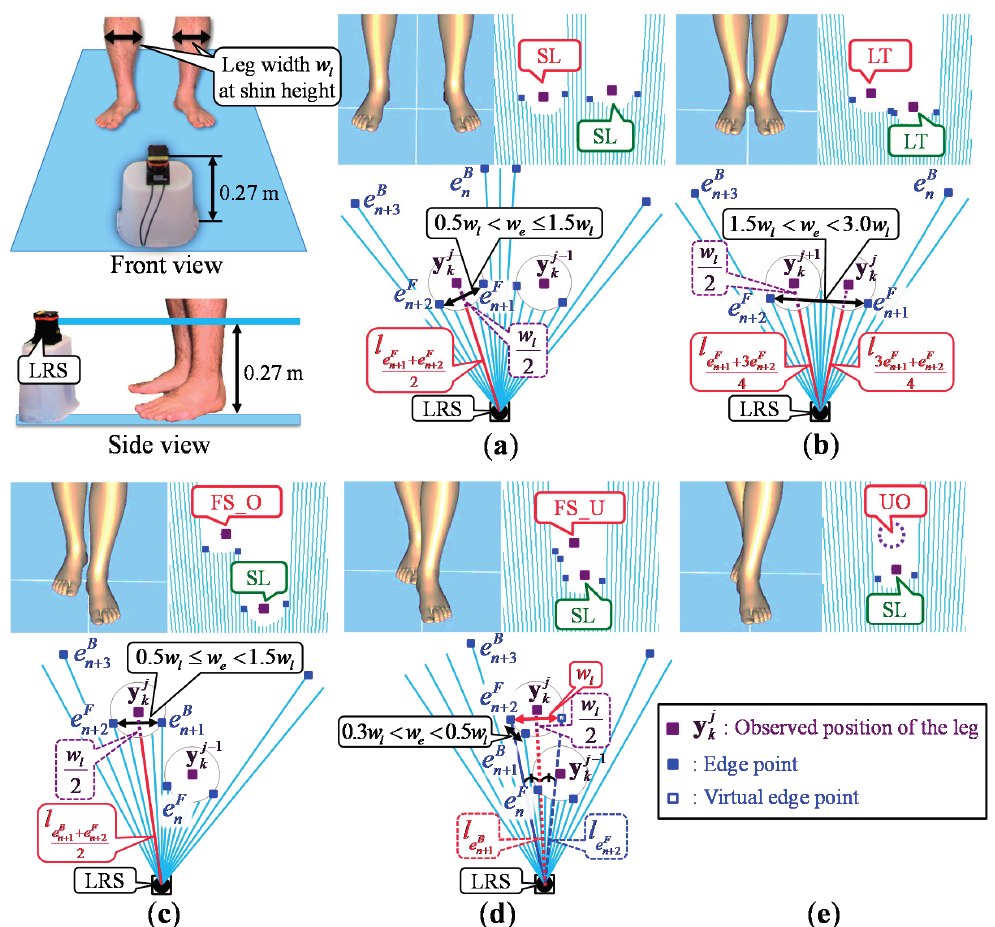
Figure 7. Leg detection using five observed leg patterns [34]. ( a ) single leg (SL) pattern; ( b ) legs together (LT) pattern; ( c ) forward straddle observable (FS_O) pattern; ( d ) forward straddle unobservable (FS_U) pattern; ( e ) unobservable (UO)